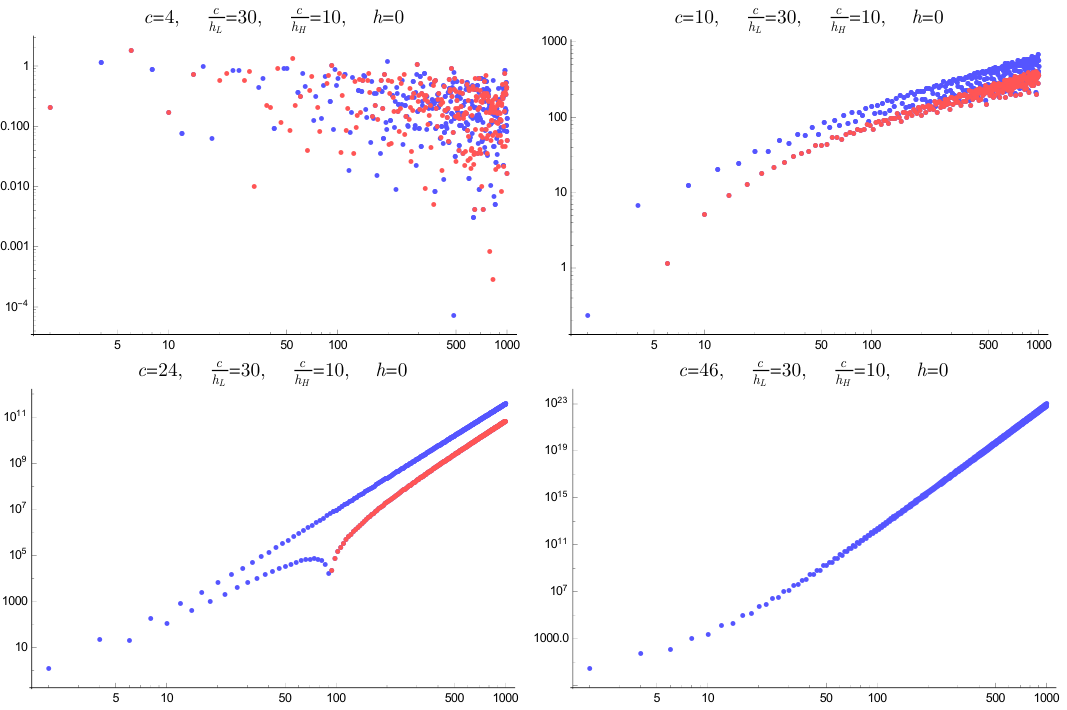
2 n expansion of H . We plot c n as a n of the q j j and h H held constant. c c